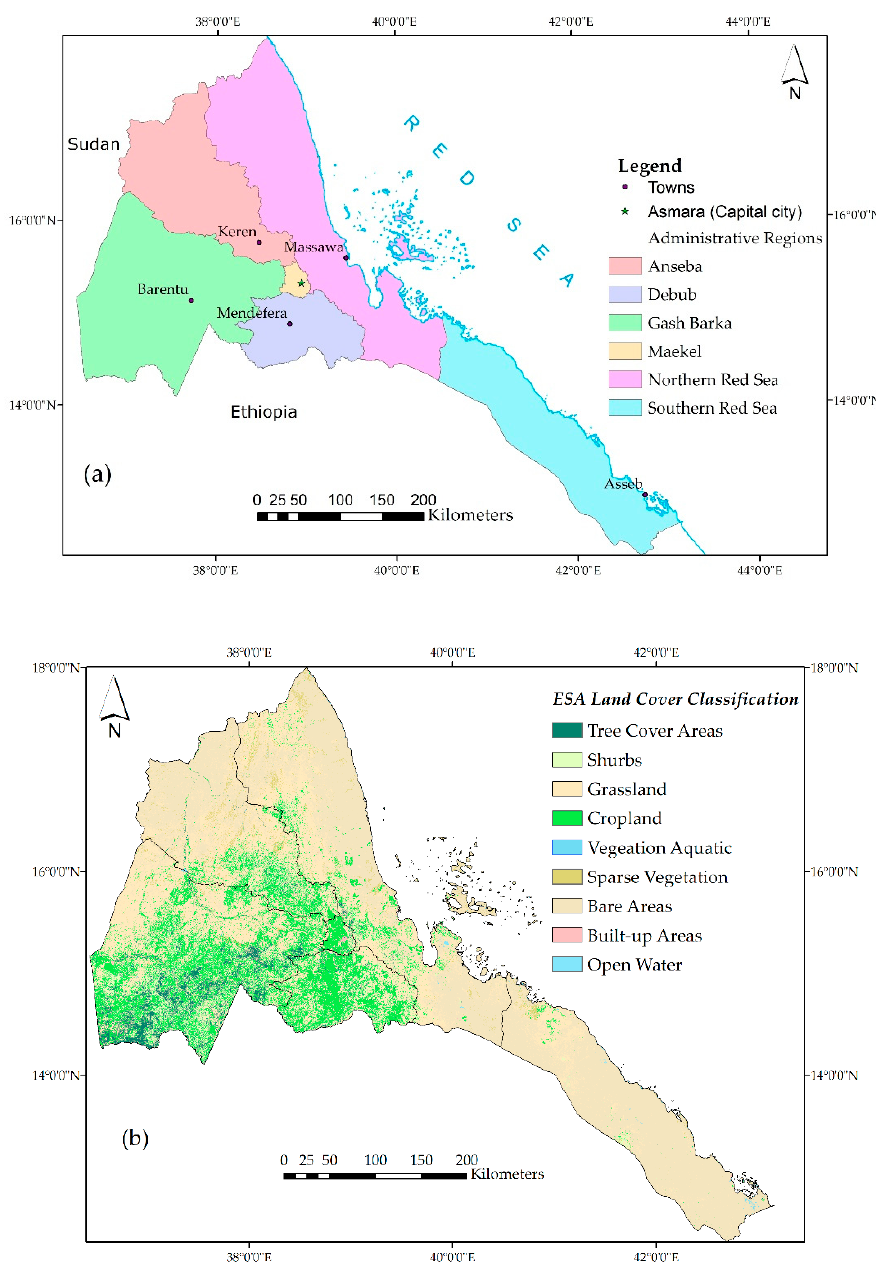
Figure 2. Administrative regions of Eritrea ( a ), and European Space Agency land cover (2016) map ( b ).